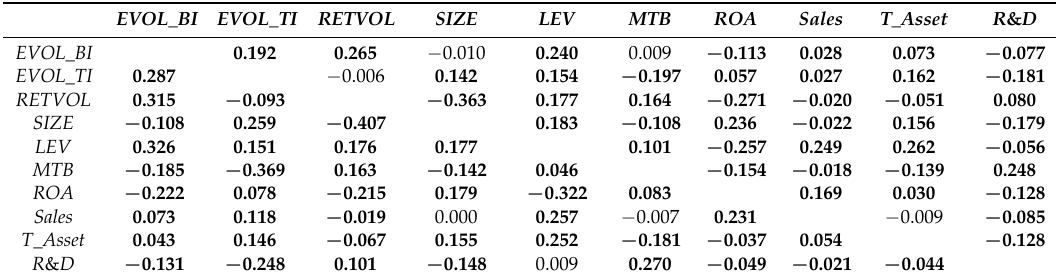
Table 2. The Pearson/Spearman Correlations among the